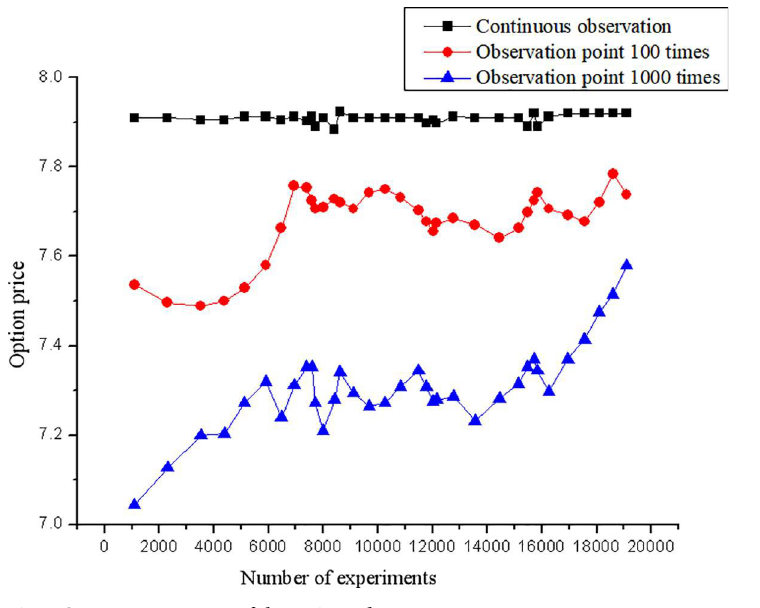
Fig 6. Convergence process of the option